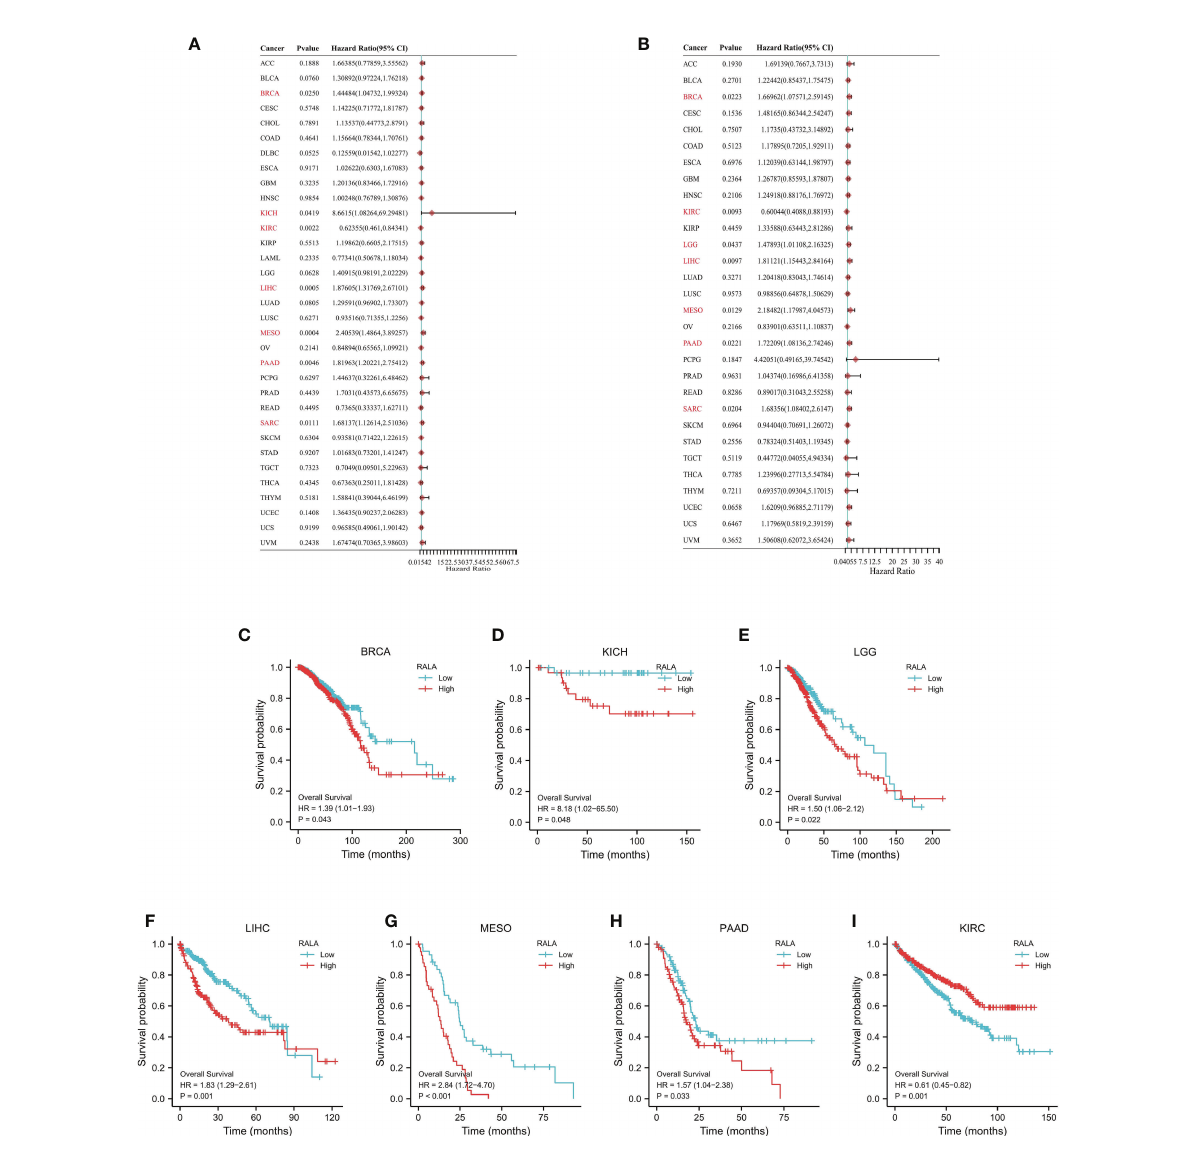
FIGURE 3 The prognostic value of RALA. The survival analysis of OS (A) and DSS (B) by RALA in pan-cancer described in the forest map. (C – I) K-M analysis curve of RALA expression and prognosis in different